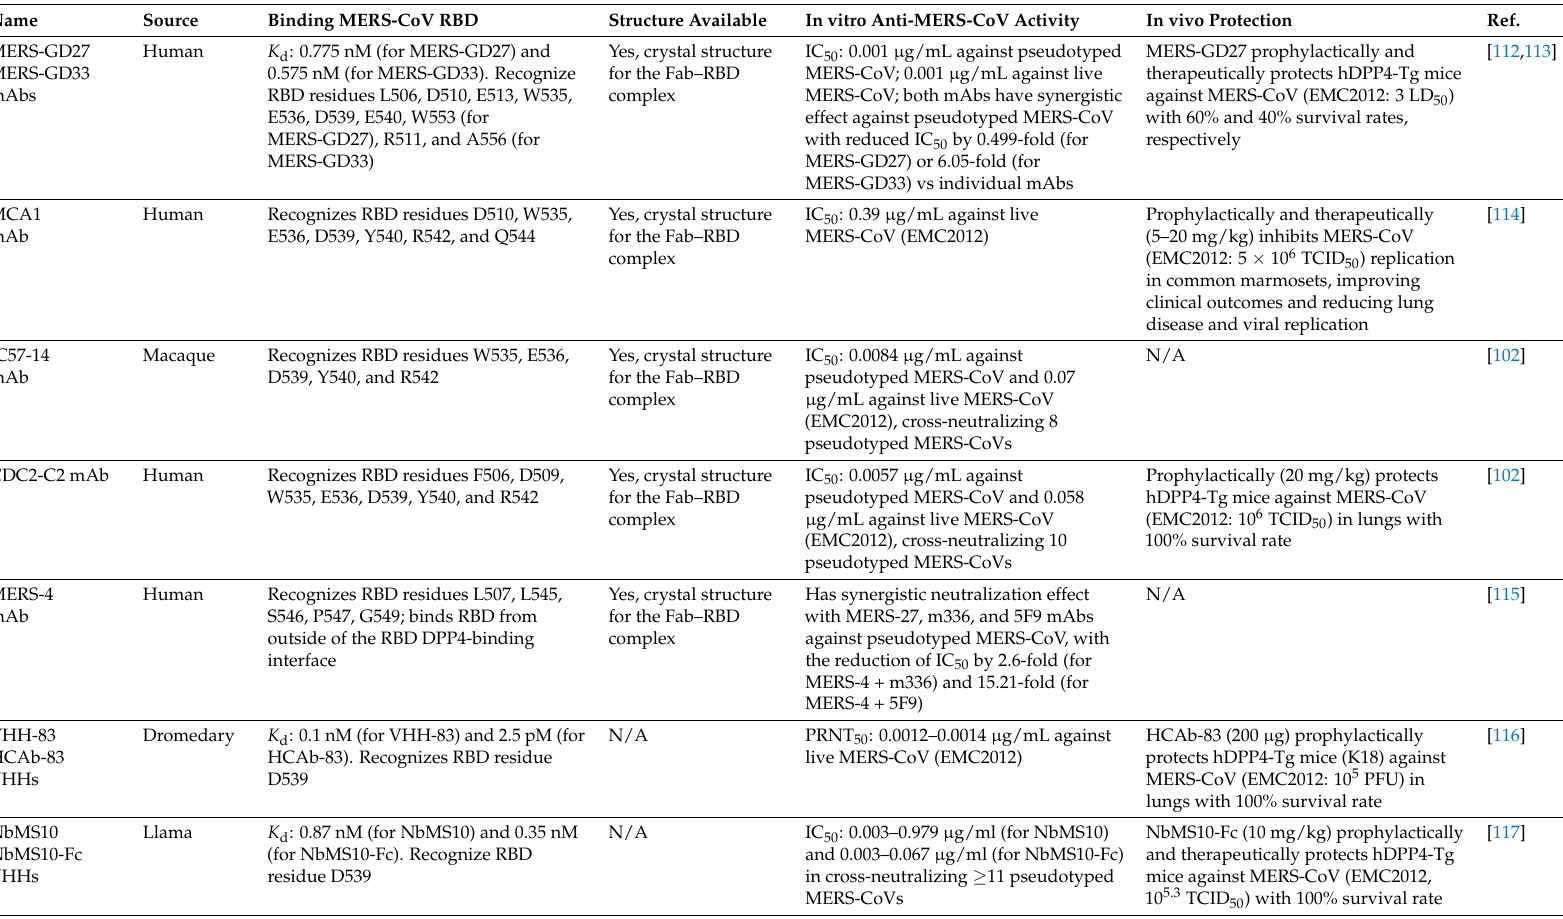
Table 2. Therapeutic antibodies targeting MERS-CoV RBD. Live MERS-CoV strains used for neutralization and challenge experiments are indicated in